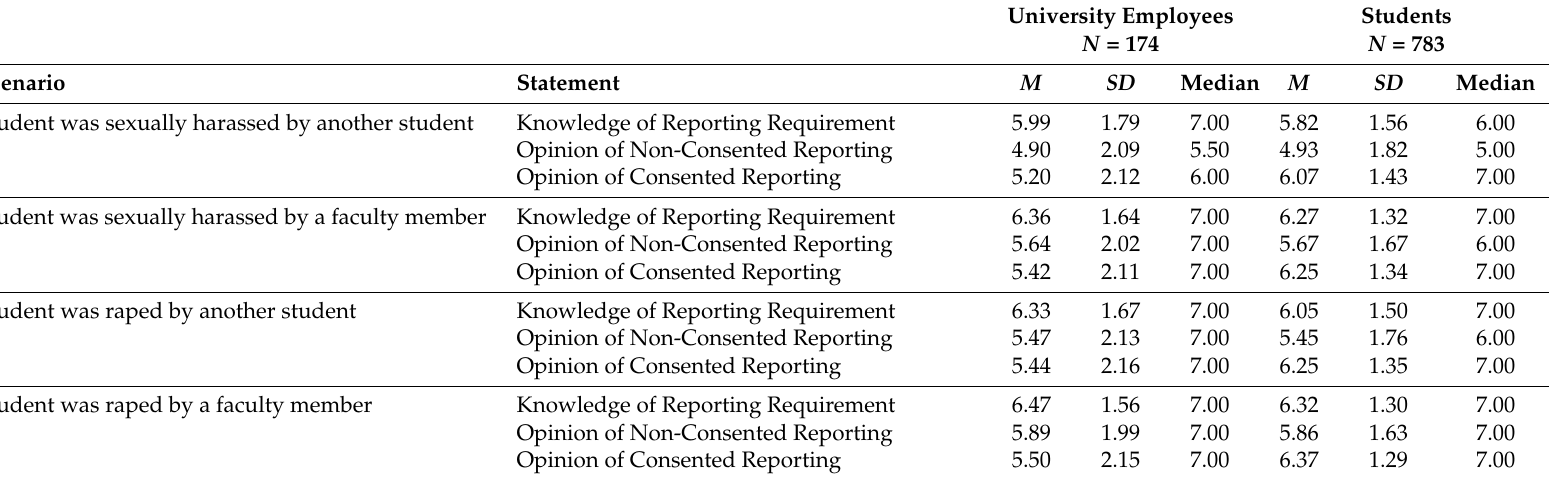
Table 1. Descriptive statistics for Title IX knowledge and opinion